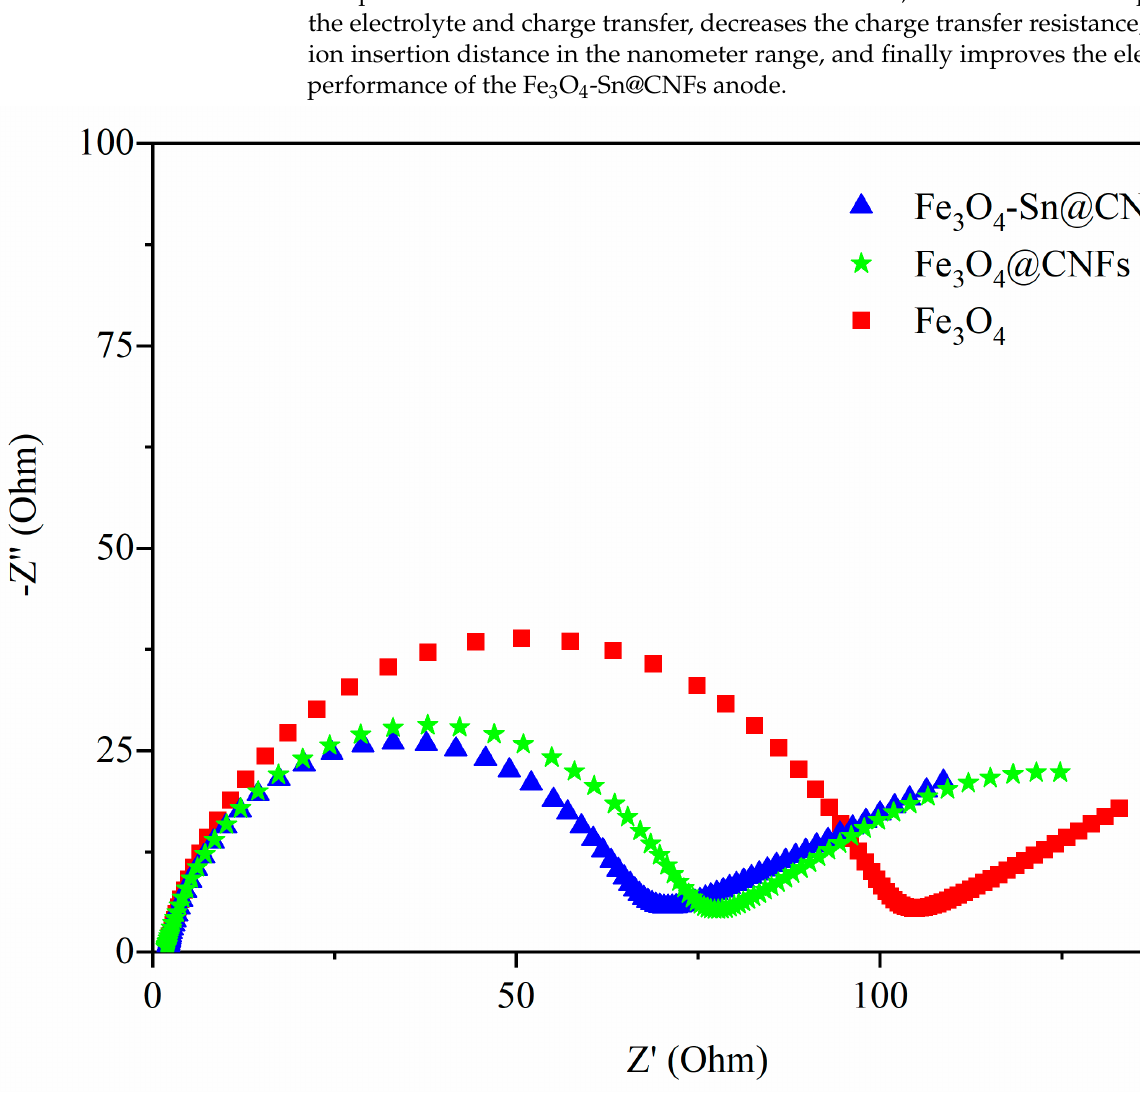
Figure 6. AC impedance spectra of Fe 3 O 4 , Fe 3 O 4 @CNFs, and Fe 3 O 4 -Sn@CNFs in 1M LiPF 6 /EC/DMC (EC: DMC = 1:1).